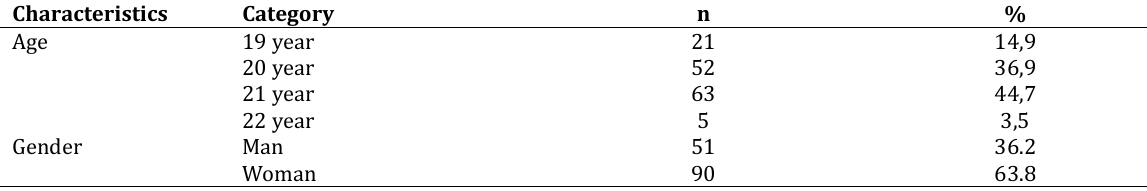
Table 1. Respondents’ Characteristics (n=141) Characteristics